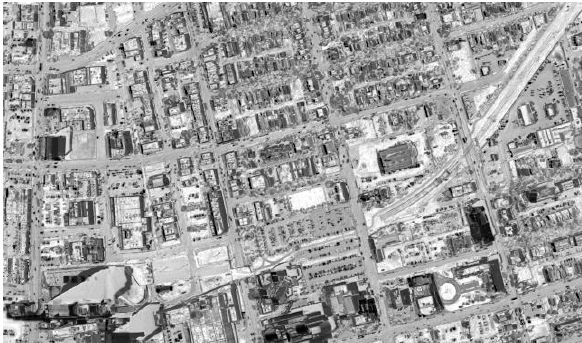
Figure 3. A constraint mask derived from the image